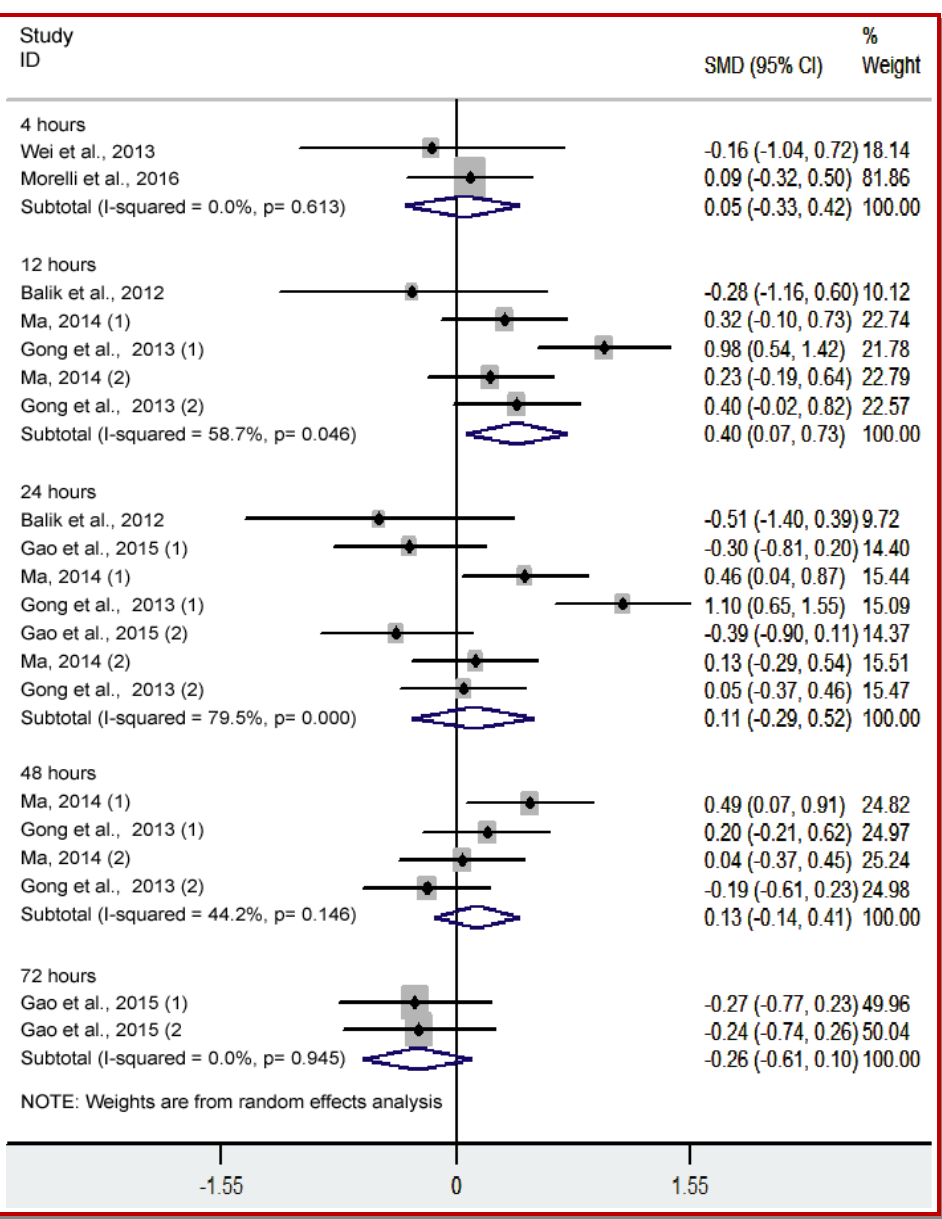
Figure 10: Meta-analysis of beta-blocker on the left ventricular ejection fraction (digit within the parenthesis means the number of studies for